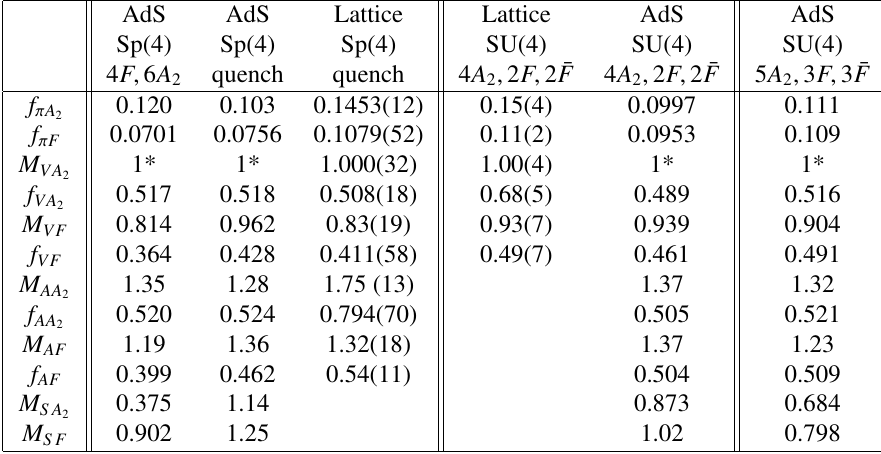
Table 1. The predictions for masses and decay constants (in MeV) for N f = 2 SU(3) gauge theory. Table 2. Ground state masses and couplings for the vector, axial-vector, and scalar mesons for the two The columns show the QCD value, the holographic prediction for the theory with massless quarks and representations, F and A 2 , for an Sp(4) and an SU(4) gauge theory. Results are shown from the lattice the perfected holographic QCD theory with HDOs. The ⇢ -meson mass has been used to set the scale (Sp(4) from [30] and SU(4) from [31] ) and from holography [7, and other quantities that are used to fix the HDO couplings are indicated by the *s.